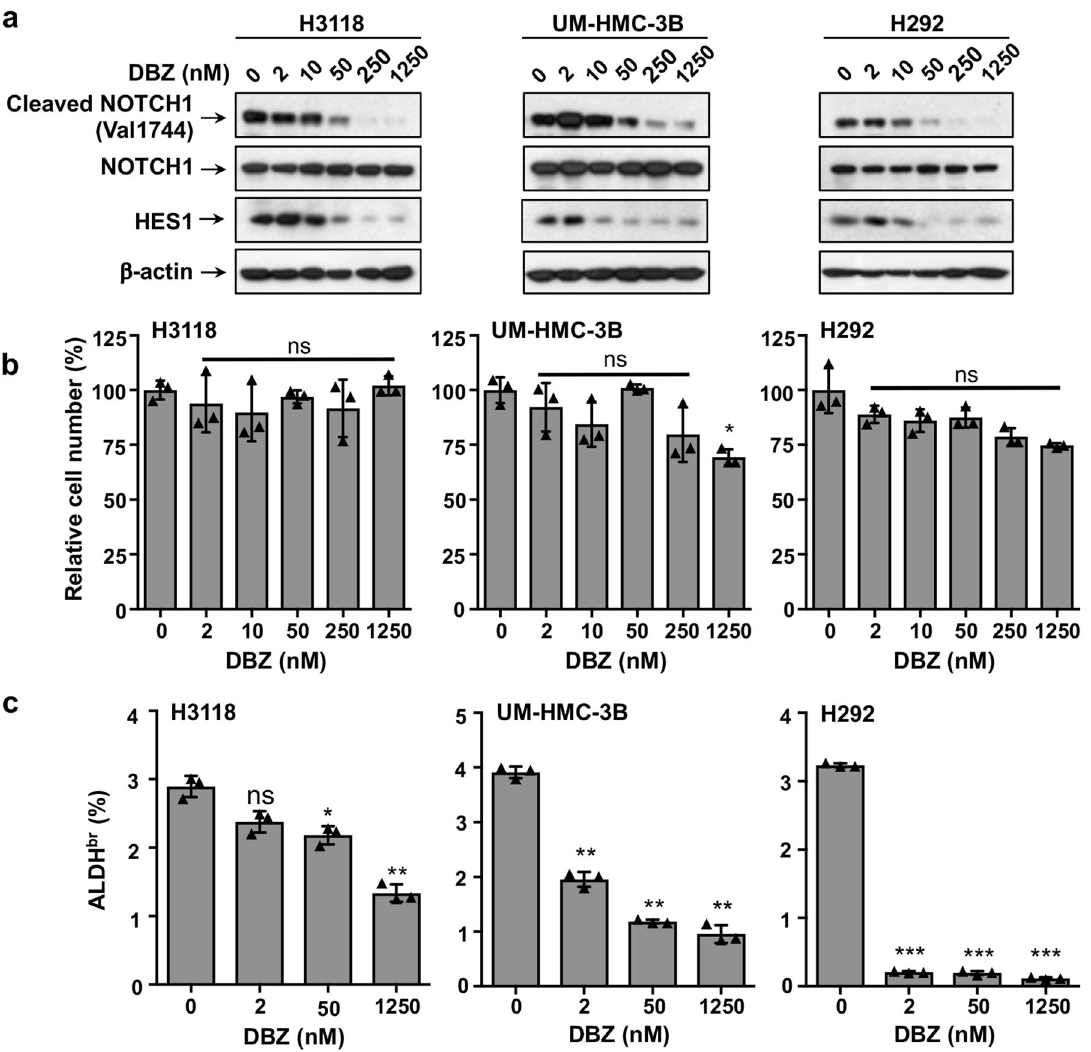
Fig. 4 Treatment with the γ -secretase inhibitor DBZ reduced the ALDH-bright population in MEC cells. a Human MEC cells (H3118, UM-HMC- 3B, and H292) were treated with various concentrations of DBZ for 72 h. The DBZ-treated cells were harvested for western blotting to analyze the levels of activated form of NOTCH1 (cleaved NOTCH1), the total NOTCH1, and HES1 proteins. b The number of the DBZ-treated cells were scored. c The DBZ-treated cells were assayed for the percentage of ALDH br cells using an ALDEFLUOR ™ Kit (ns, p > 0.05; * p < 0.05; ** p < 0.01; *** p <